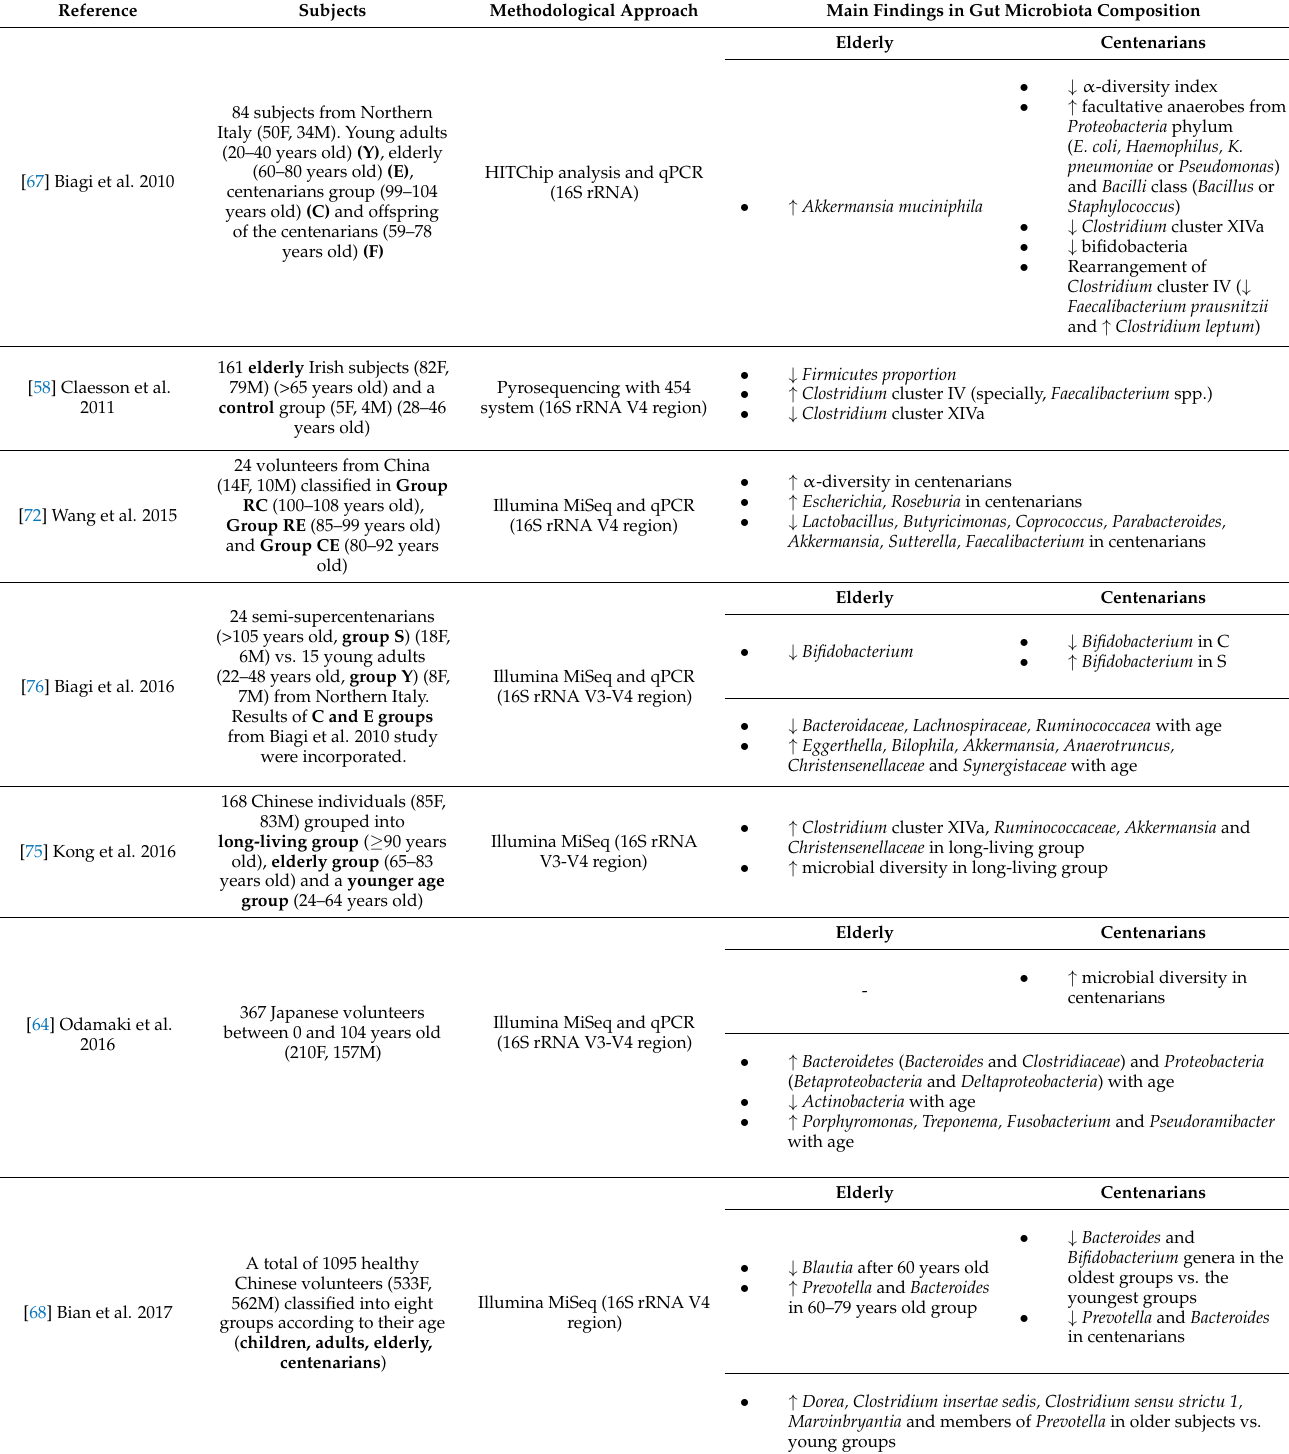
Table 1. Gut microbiota composition of the elderly ( ≥ 60 years old) and centenarians ( ≥ 99 years